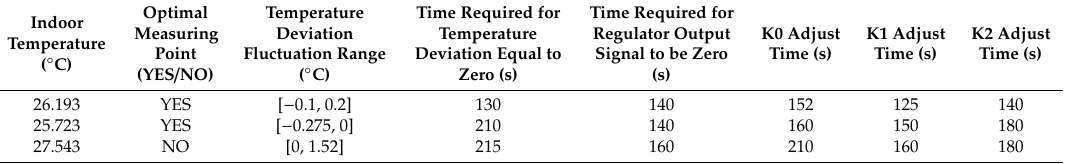
Table 15. Comparison of temperature simulation operation of optimal temperature and ambient